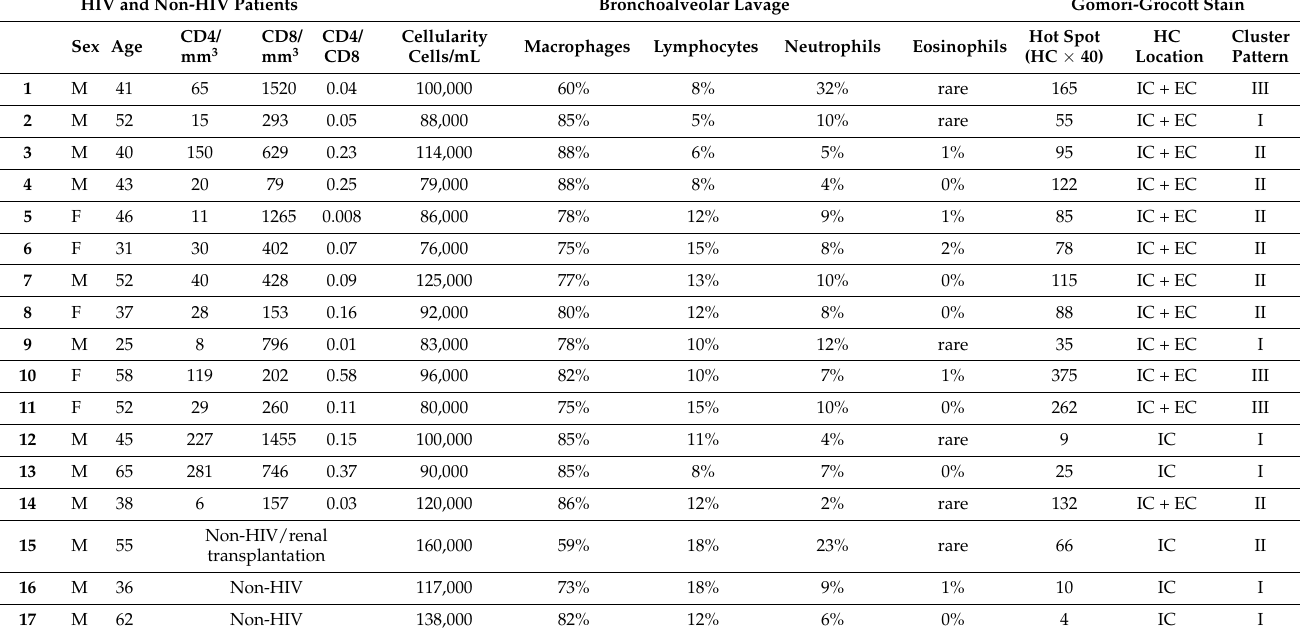
Table 1. Data from the 17 patients (14 HIV and 3 non-HIV) with pulmonary histoplasmosis. The characteristics of their BALs (cellularity and cell formula) and the Histoplasma capsulatum yeasts detected by the Gomori-Grocott stain at a × 40 field (hot spot). HC: Histoplasma capsulatum. IC: intracellular; EC: extracellular. Cluster’s pattern: type I: small cluster or chain < 5 yeasts; type II: I + cluster or chain > 5 yeasts; type III: II +